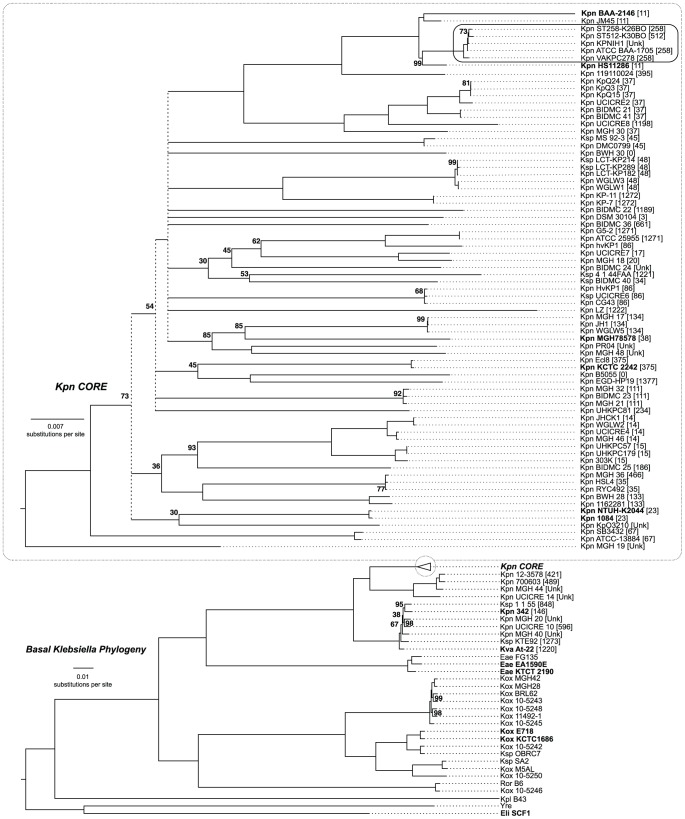

Klebsiella phylogeny.Tree for 108 genomes based on a 2.93-Mbp alignment, rooted at the midpoint of the outgroup (Ecl/Yre) branch. Nodes with <30% bootstrap support were combined forming the multifurcated dashed line; otherwise support values are shown only when <100%. Brackets: Kpn multilocus sequence type (ST). Inset: enlargement of the “core Kpn” phylogeny. Kpn2146 falls in a clade containing fellow ST11 strains Kpn JM45 and Kpn HS11286 and a tight clade (circled) of ST258 and ST512 strains. The ST258/ST512 clade is heavily sequenced, and represented here with only five of its most diverse members. Bold: complete genomes used for phyloblocks analysis. Species name abbreviations: Kpn, K. pneumoniae; Ksp, K. sp.; Kpl, K. cf. planticola; Kox, K. oxytoca; Kva, K. variicola; Eae, Enterobacter aerogenes; Ecl, E. cloacae; Ror, Raoultella ornithinolytica; Yre, Yokanella regensburgei.